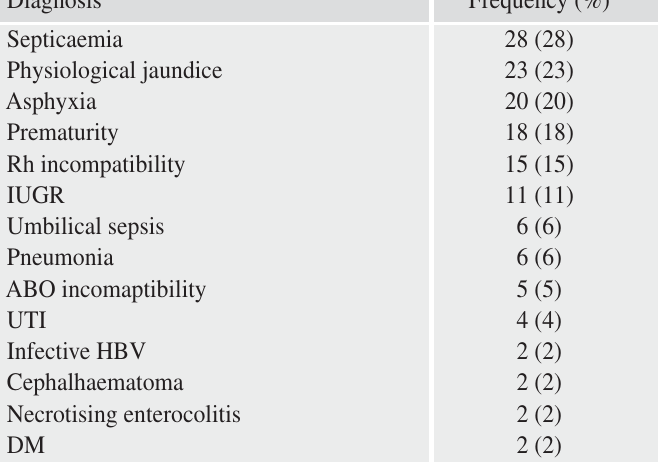
Table IV: Distribution of patients by diagnosis (n=100) Diagnosis